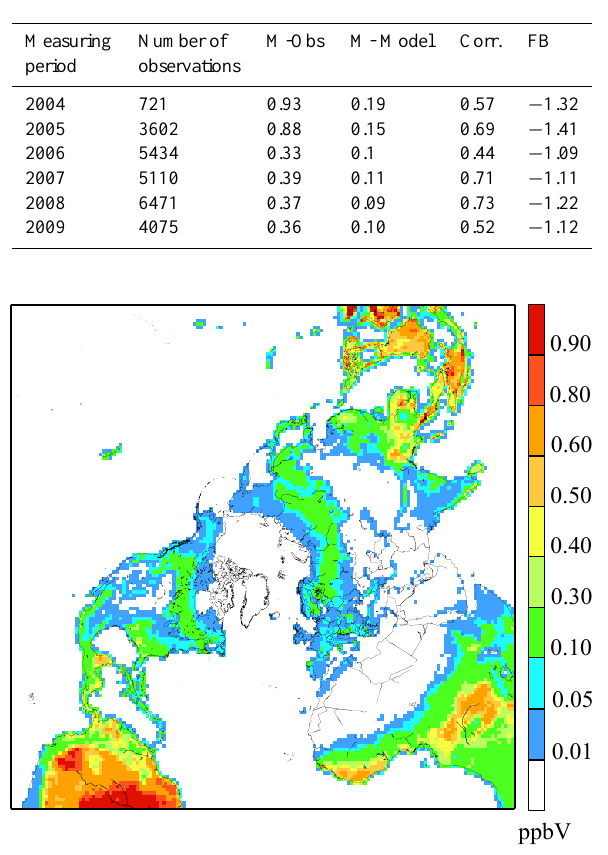
Fig. 1. Spatial distribution of the annual average monoterpenes mix- ing ratios (ppbV) simulated by DEHM in the lowest model layer using the MEGAN biogenic emission model for 2006.